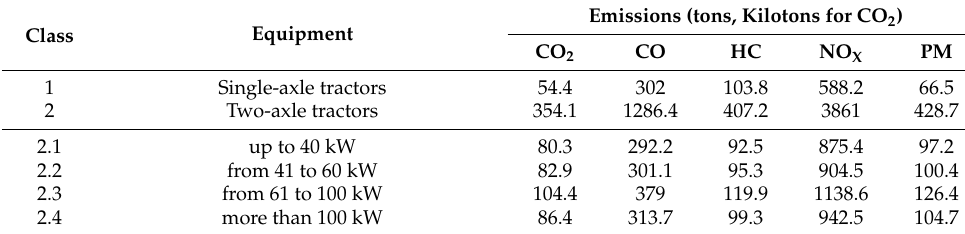
Table 5. Emissions for all the equipment categories in